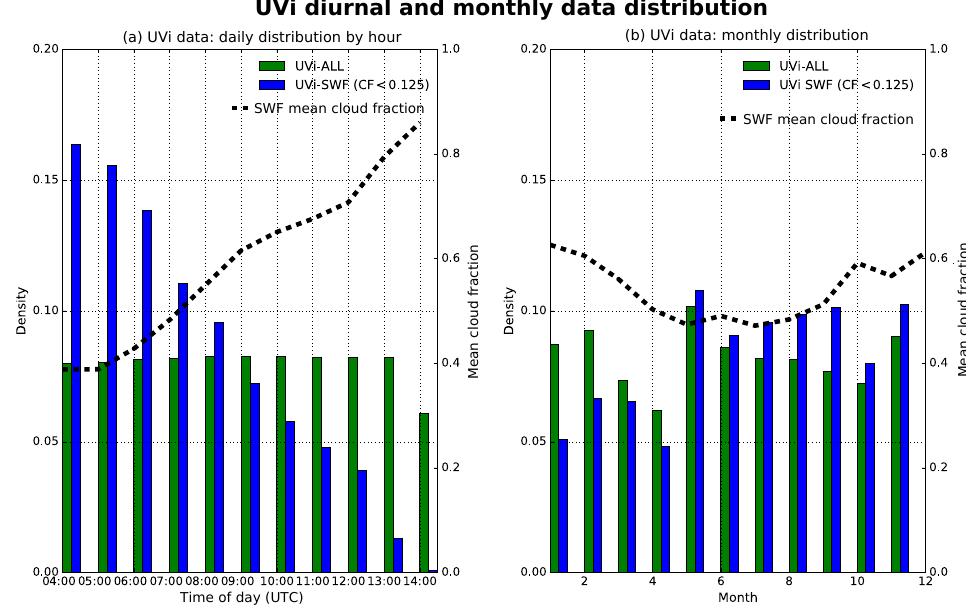
Figure 2. UVI data distribution and cloud fraction for 1h bins. UVI-ALL is in green, UVI-SWF is in blue, cloud fraction is indicated by the dotted